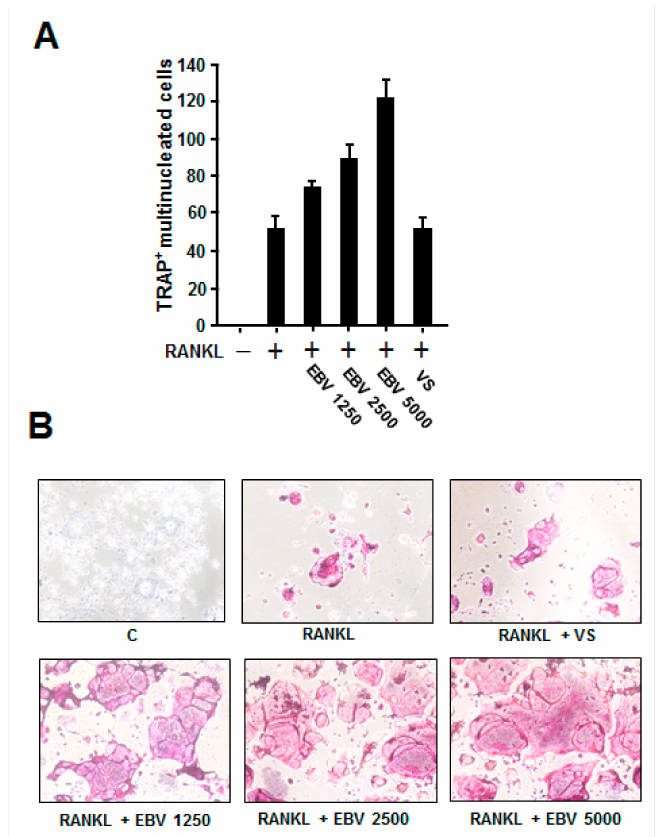
Figure 4. Induction of RANKL-induced osteoclast differentiation by EBV. RAW264.7 cells were seeded in a 96-well plate and treated with recombinant RANKL (50 ng/mL) in the absence or presence of the indicated copy numbers of EBV (copies/mL) for 4 days, followed by TRAP staining. ( A ) The number of TRAP-positive multinucleated cells present in each well was counted. “VS” indicates treatment with virus-treated stock solution. ( B ) TRAP-positive multinucleated cells were observed by light microscopy. RANKL, receptor activator of nuclear factor kappa B ligand; EBV, Epstein–Barr virus; TRAP, tartrate-resistant acid